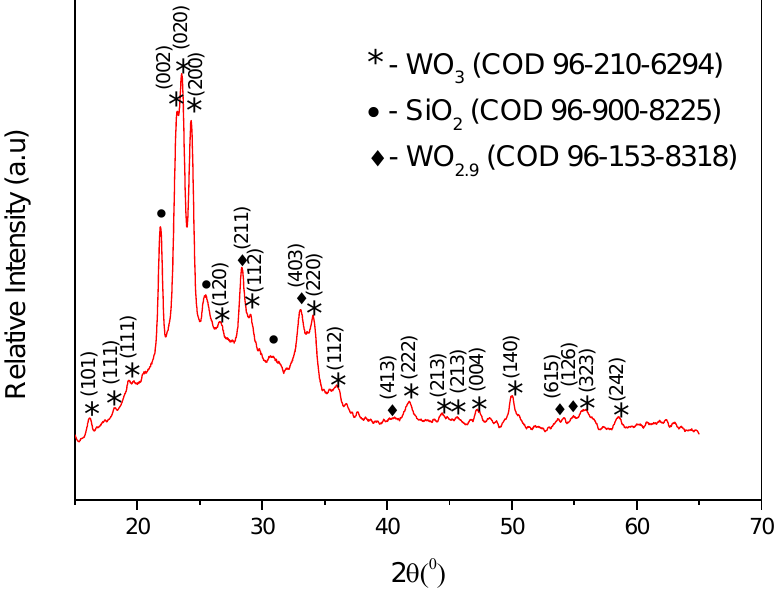
Figure 4. XRD spectrum of WO 3 / WO 3 − x -based layer prepared from PTA + EtOH sol-gel and annealed at 500 °C for 2 h.